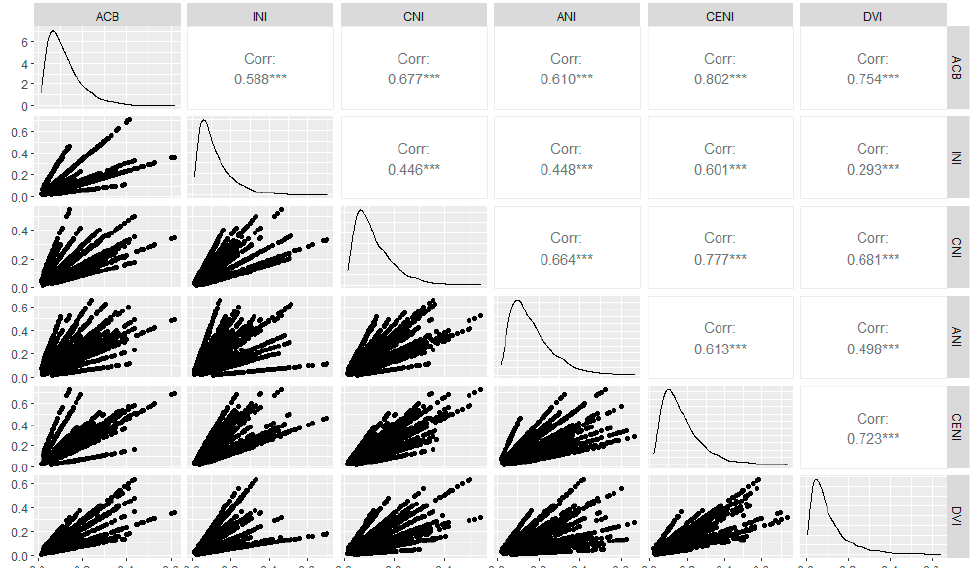
Figure 7. Correlation matrix between RPF factors and Composite Index of Online Purchasing Behavior as of October 2020. Source: developed by the authors. *** p ≤ 0.001.